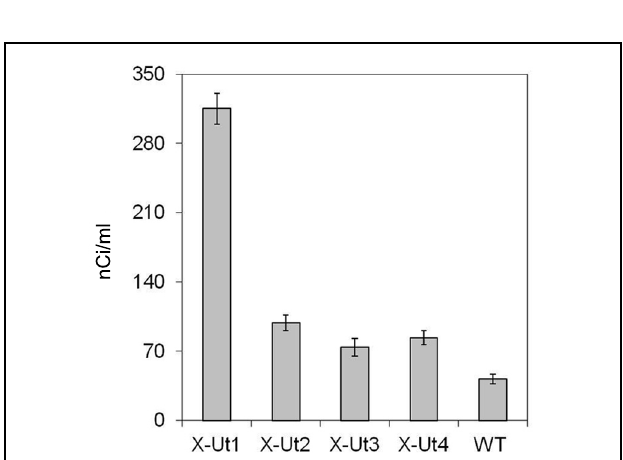
FIGURE 6 | Demonstration of D -[ 14 C] xylose uptake. To demonstrate the uptake of xylose, cultures of Synechocystis transformant strains, X-Ut1, X-Ut2, X-Ut3, and X-Ut4, and the WT strain at an OD 730 of 0.6 were grown in the presence of D -[ 14 C] xylose. Radioactivity detected in the cultures is represented in nCi/ml. Data were collected from three biological replicates and presented as means ± standard deviations.